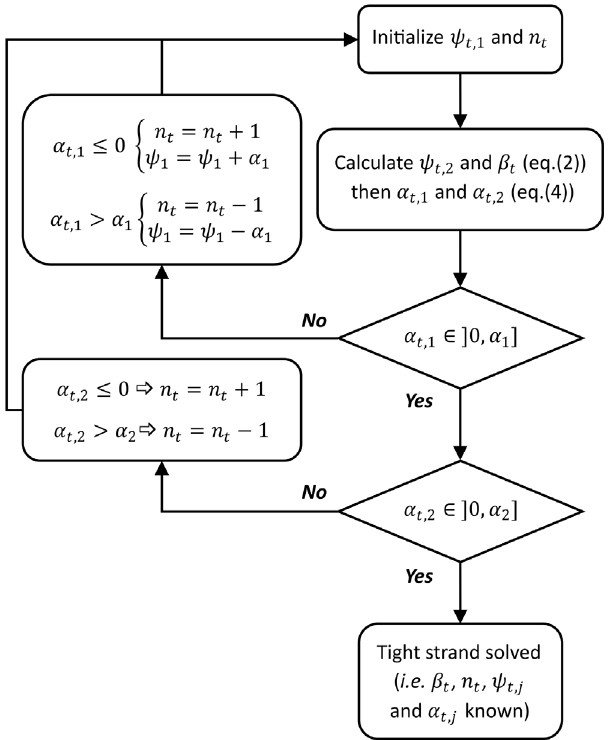
Fig. 8. Flow chart for the tight strand computation.